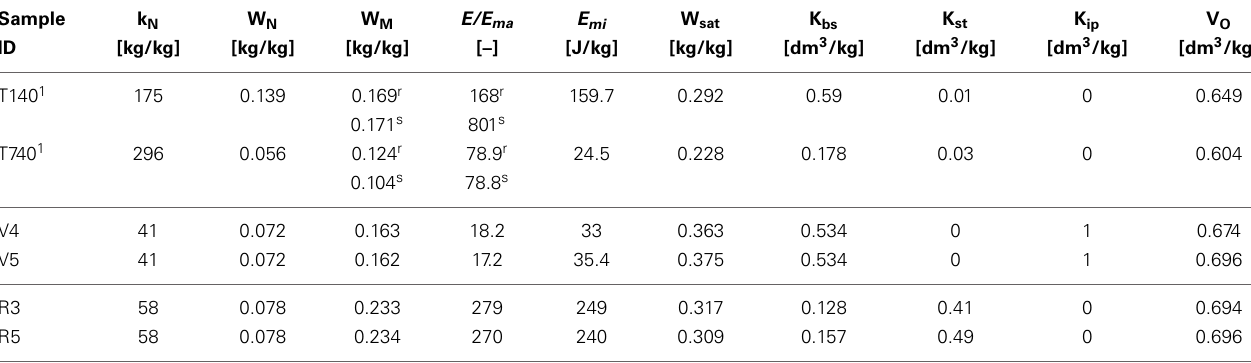
Table 4 | Pedostructure thermodynamic equilibrium parameters calculated from the shrinkage curve and the water tension curve of the soil (pedostructure)